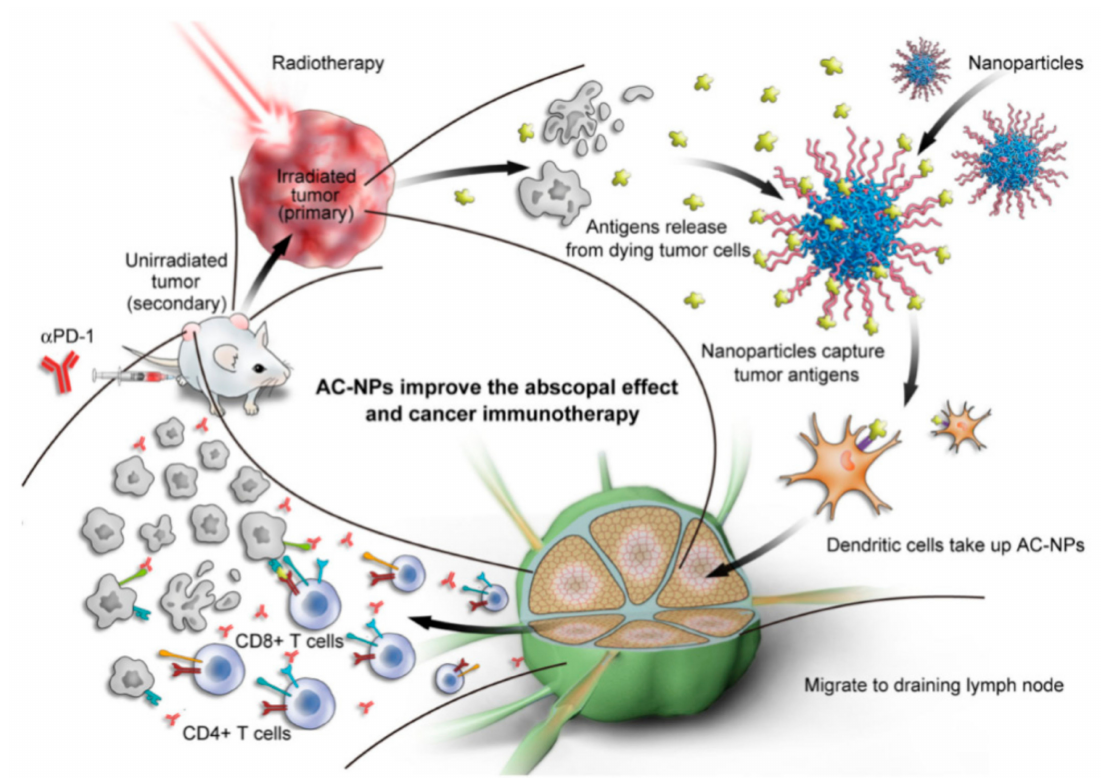
Figure 4. The protein corona in cancer immunotherapy. Schematic description of an NP–PPC based therapy mechanism in which radiotherapy induces the release of tumor-derived protein antigens (TDPAs) that are integrated in the PC and promote the antigen presentation and the anti-cancer immune activation. This approach is applied in combination with checkpoint inhibitor therapy. Figure from